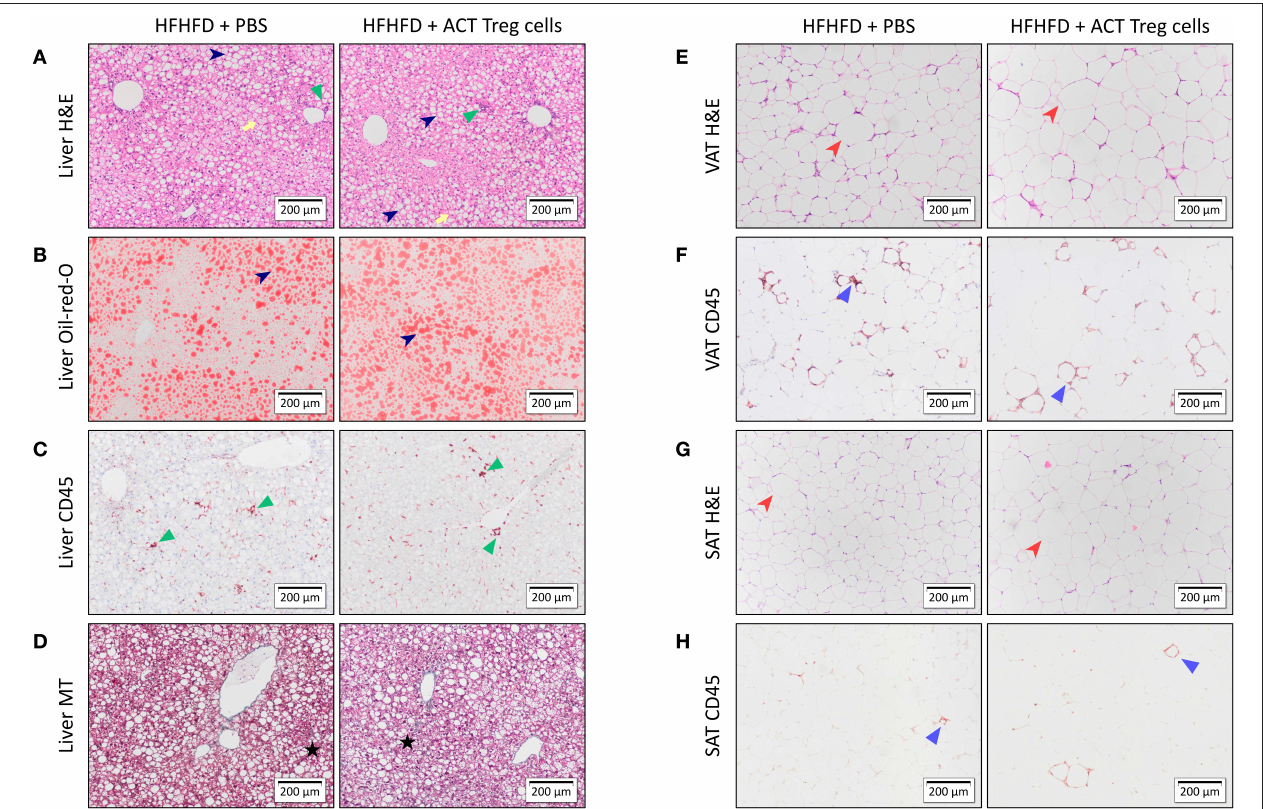
FIGURE 4 | Representative 10x images of liver and adipose tissue histology showing the effect of an ACT of Treg cells on HFHFD-induced NASH. Histological staining was performed on liver tissue with (A) H&E, (B) Oil-red-O, (C) CD45 immunohistochemistry, and (D) Masson’s trichrome; on VAT with (E) H&E and (F) CD45 immunohistochemistry; and on SAT with (G) H&E and (H) CD45 immunohistochemistry. At the level of the liver, the ACT caused an exacerbation of steatosis (dark blue arrowhead), while not affecting hepatic inflammation (green triangle) or hepatic fibrosis (black star). Ballooning is marked with a yellow arrow. At the level of VAT and SAT, no effect of the ACT was observed on adipose tissue diameter (red arrowhead) or adipose tissue inflammation (blue triangle). ACT, adoptive cell transfer; H&E, hematoxylin-eosin; HFHFD, high-fat high-fructose diet; MT, Masson’s trichrome; PBS, phosphate-buffered saline; SAT, subcutaneous adipose tissue; Treg, regulatory T; VAT, visceral adipose